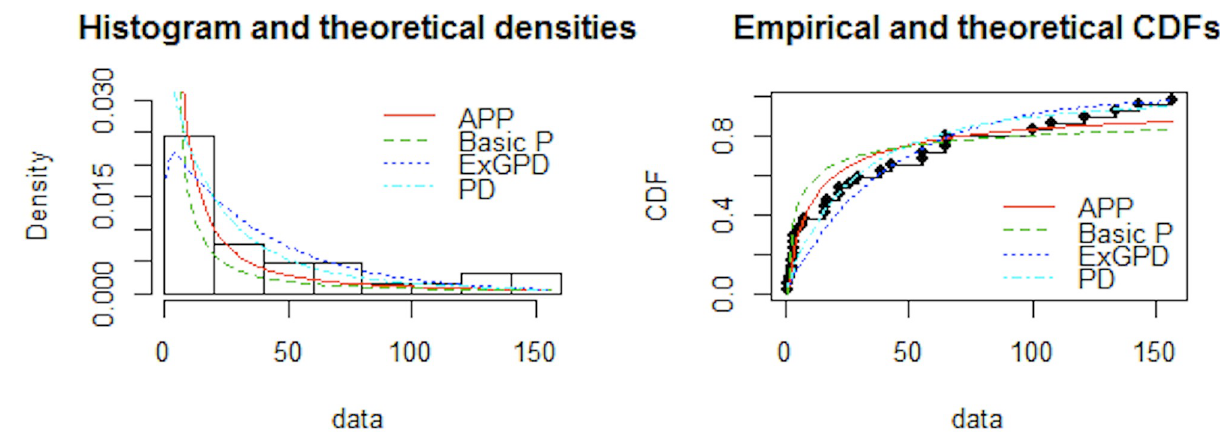
Fig 4. Comparison between fitted distributions for dataset